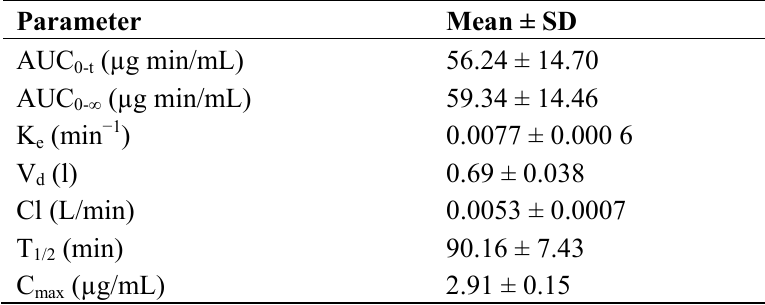
Table 3. Pharmacokinetic parameters of BHMC obtained by means of non-compartmental analysis following i.v. administration of 10 mg/kg in rats (n =